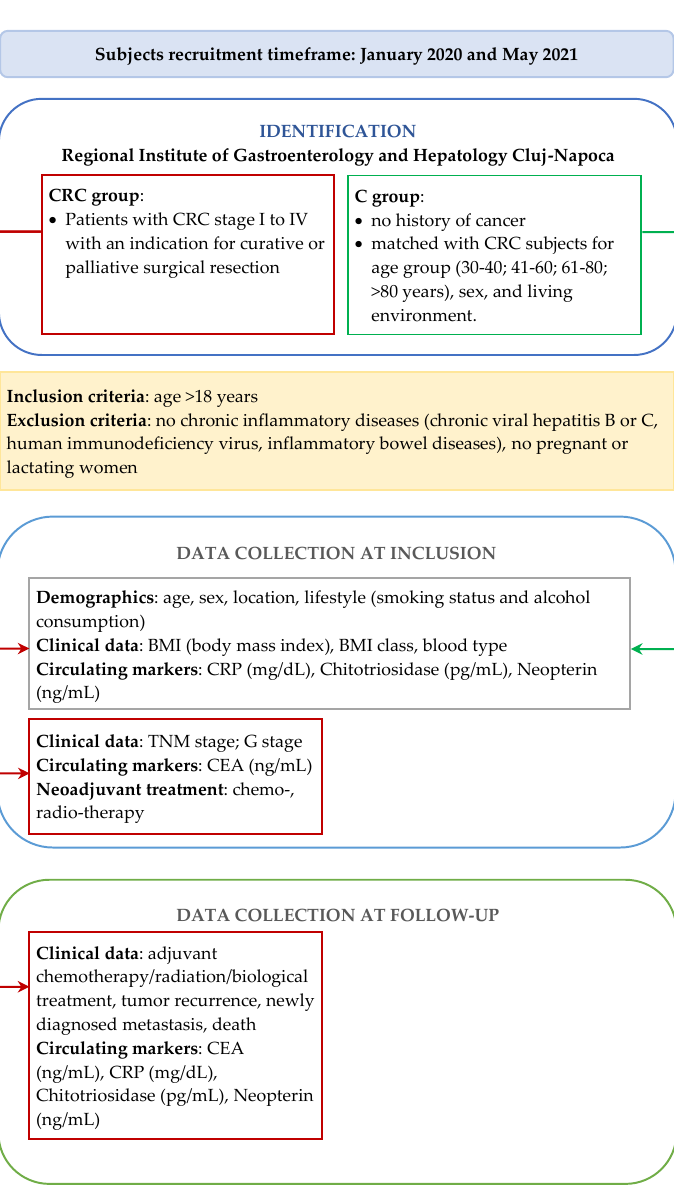
Figure 1. Flowchart of study design. CRP — C-Reactive Protein; CEA — CarcinoEmbryonic Antigen.